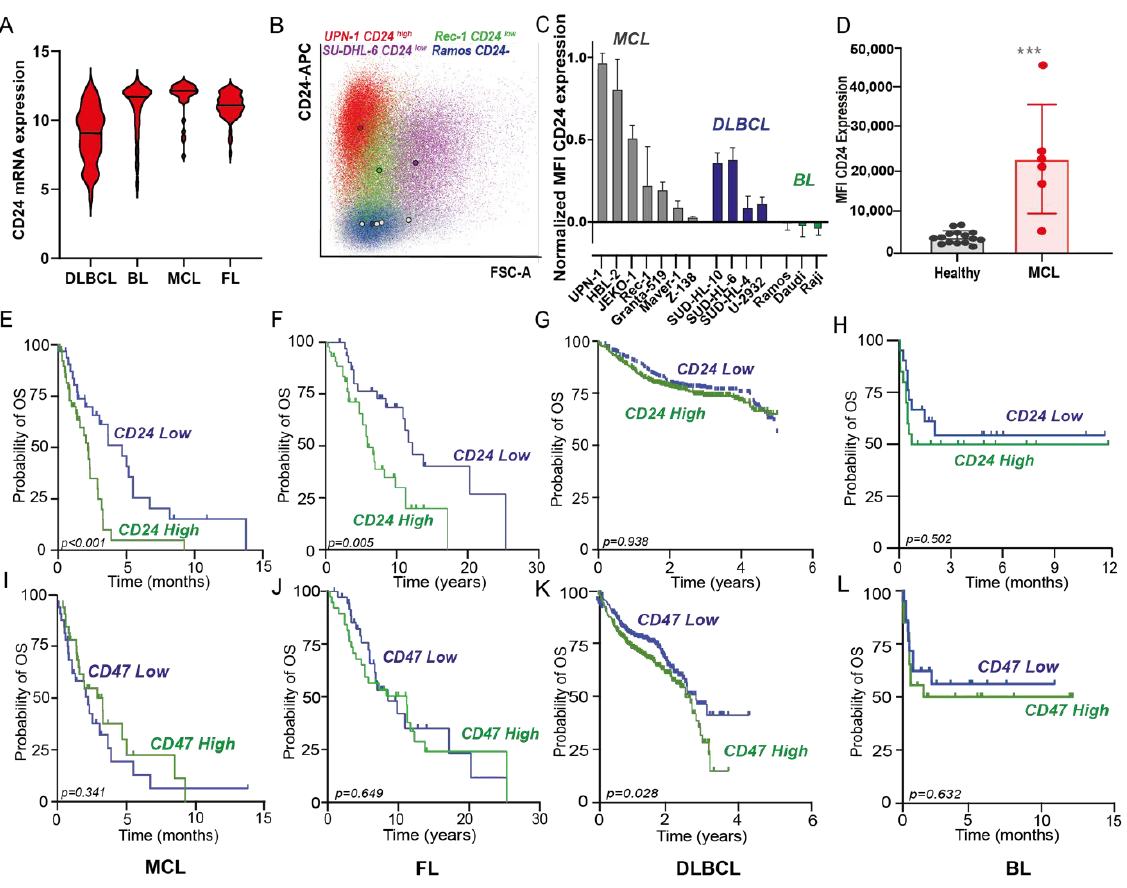
Figure 1. CD24 expression in several non-Hodgkin’s lymphomas (NHL) and correlation with survival. ( A ) CD24 mRNA expression (2log) in 4 subtypes of NHL, namely diffuse large B-cell lymphoma (DLBCL; n = 94), Burkitt lymphoma (BL; n = 58), mantle cell lymphoma (MCL; n = 42), and follicular lymphoma (FL; n = 64). ( B ) Dot-plot diagram of forward scatter vs. CD24 expression of representative cell line panel, illustrating high CD24 expression (UPN-1, red), low CD24 expression (Rec-1, green; SU-DHL-6, violet), or lack of CD24 expression (Ramos, blue) compared to isotype controls (gray). The colored circles indicate the mean value of the population. ( C ) Surface CD24 expression (mean ± SD of corrected MFI values, n = 3) in MCL, DLBCL and BL cell lines. Expression was normalized to the highest value, corresponding CD24 expression of UPN-1. ( D ) Surface CD24 expression (MFI values) of MCL blast cells (CD45+CD19+CD5+) ( n = 6) and healthy donors ( n = 13) (CD45+CD19+) cells. Mean ± SD, Student ’s t -test, *** = p < 0.001 ( E – H ) Kaplan – Meier plots for CD24 and (I – L ) CD47 expression in an MCL patient data set ( n = 71) ( E , I ), an FL patient data set ( n = 77) ( F , J ), a DLBCL patient data set ( n = 1017) ( G , K ), and BL patient data set ( n = 41) ( H , L ); log-rank test performed in all cases, with p < 0.05 considered significant.